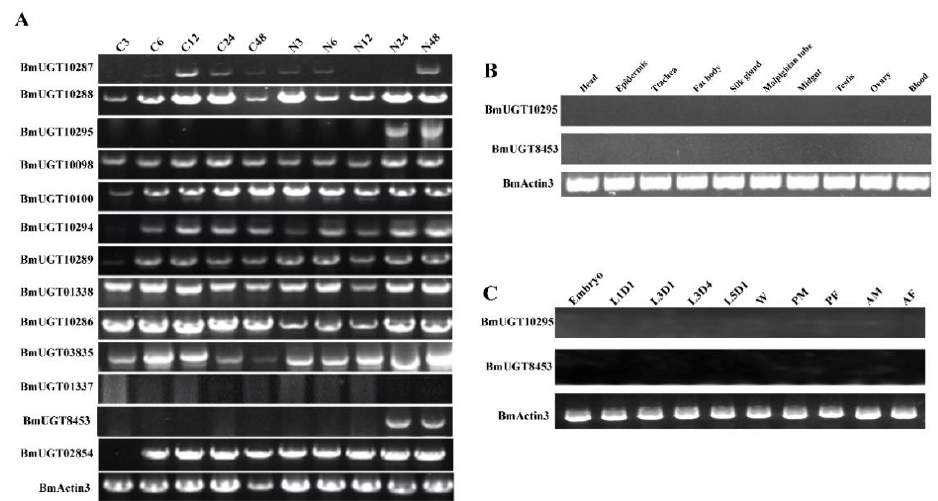
Figure 1. Transcription of Nosema bombycis -inducible BmUGT genes. ( A ): Different expression pat- terns of BmUGTs in response to N. bombycis . N3–N48 represents the silkworm samples at 3~48-h post-infection, whereas C3–C48 represent the control group, which was given water. ( B ): BmUGT10295 and BmUGT8453 transcription in the different tissues of uninfected silkworms on day 3 fifth instar larvae using actin3 (BmActin3) as internal reference. ( C ): BmUGT10295 and BmUGT8453 transcription in different larval growth stages. RT-PCR was used to analyze the expression characteristics of BmUGT10295 and BmUGT8453 in embryos, 1-day-old first instar larvae (L1D1) to 1-day-old fifth instar larvae (L5D1), wandering larvae (W), male and female pupae (PM/PF), and male and female adults (AM/AF) of uninfected B. mori .